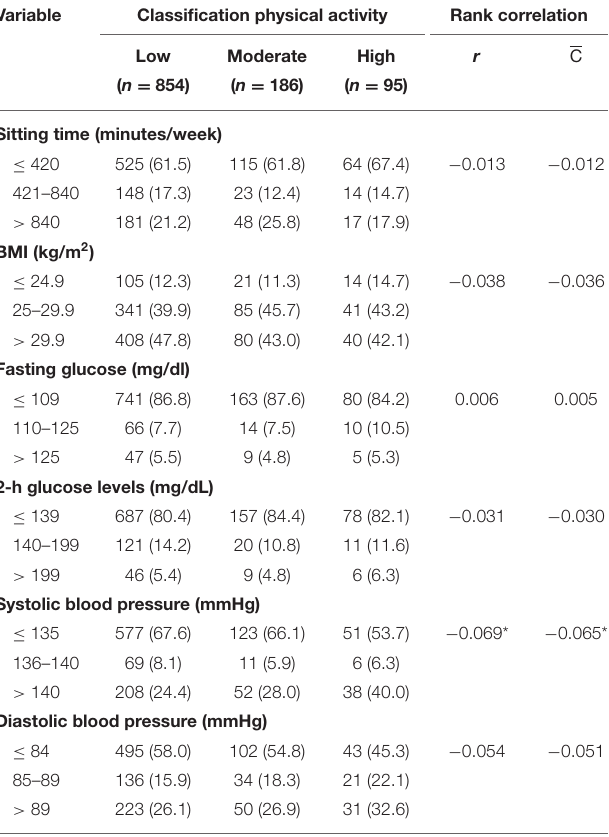
TABLE 2 | Characteristics of study participants of PREDICOL according to their level of physical activity. Variable